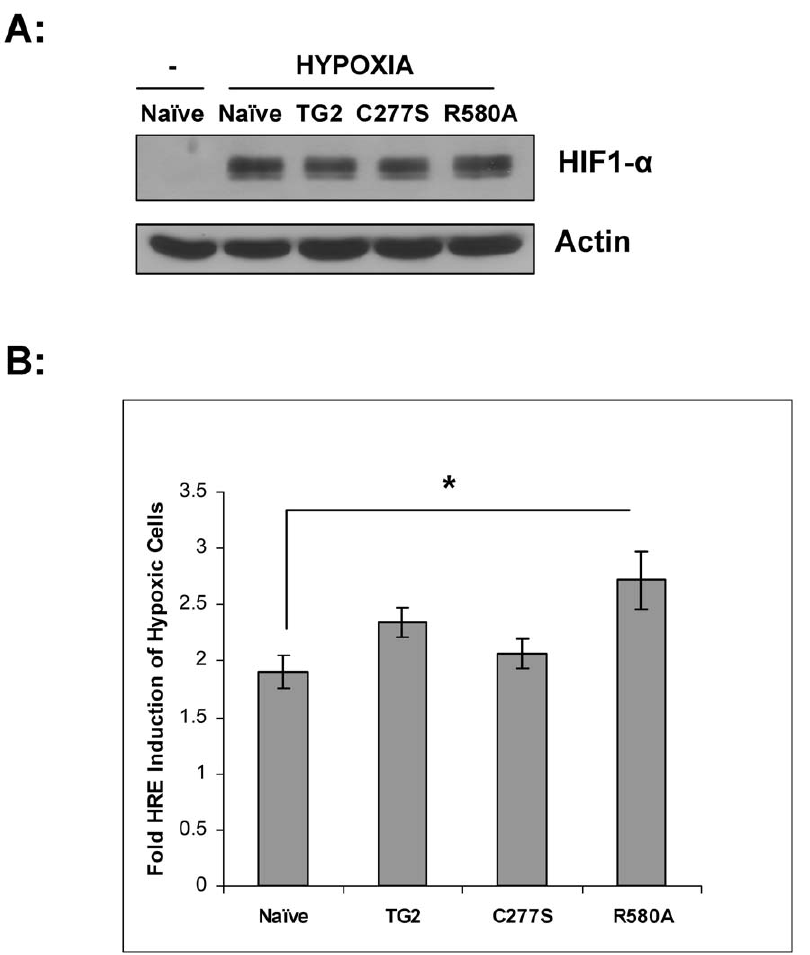
Figure 4. HRE luciferase assay. A , Immunoblots of the cell lysates from striatal stable cells showing the HIF-1 a protein stabilization after 16 h of 0.1% O 2 . ( 2 ) represents naı¨ve cells maintained in normoxic conditions. Lysates were also probed for actin as a loading control. B , Fold HRE luciferase activity of stable striatal cells after 16 h of 0.1% O 2 . TG2-R580A (R580A) cells showed significantly higher HRE activation than the other cell lines. (N=8) Results are shown as mean + / 2 SE, *p , 0.05.